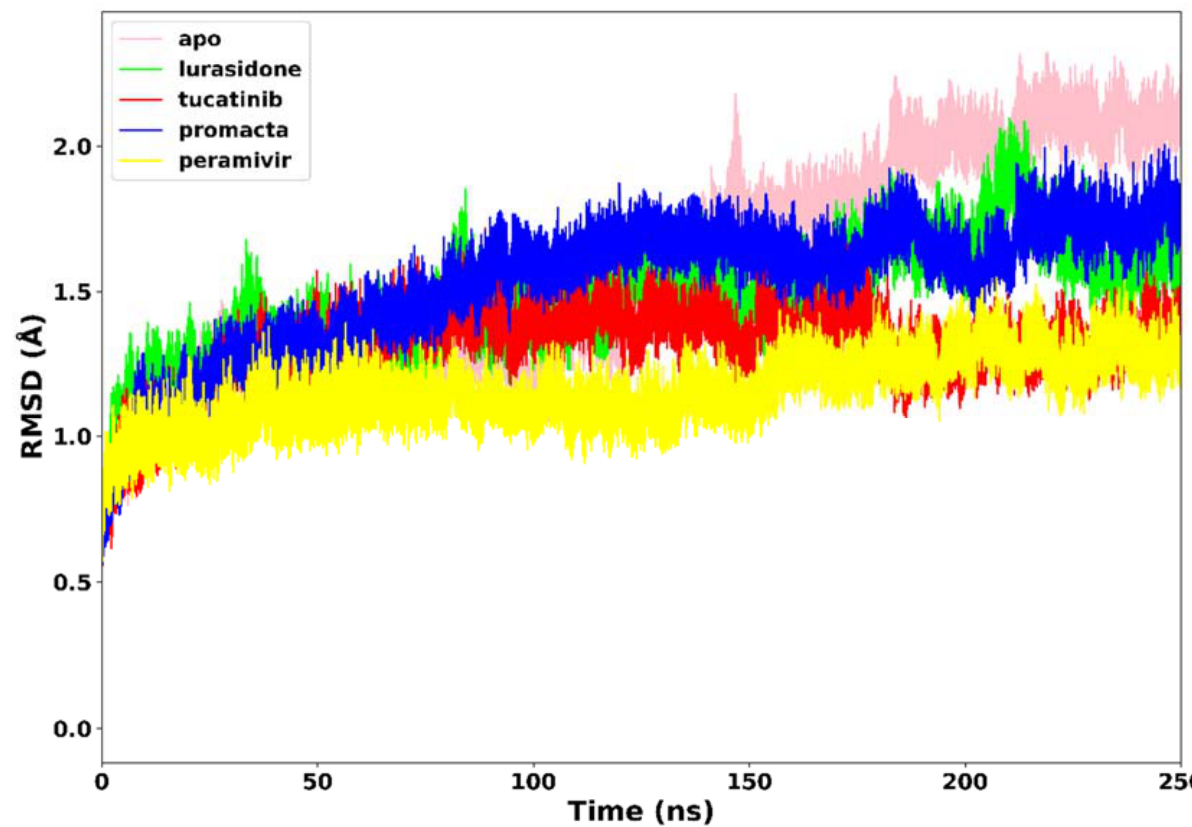
Figure 4. The RMSD trajectories of NA–ligand complexes during 250 ns simulations.